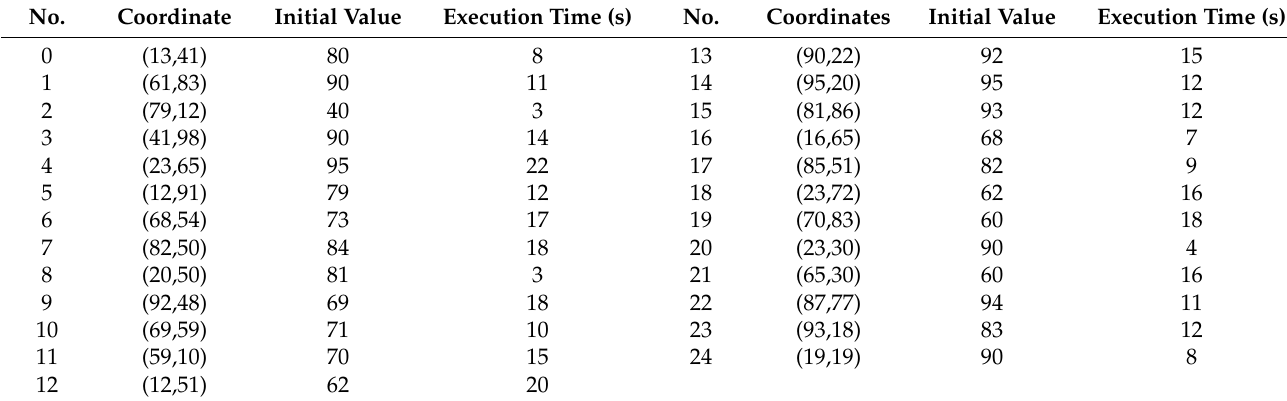
Table 5. The attributes of targets in Example 1.